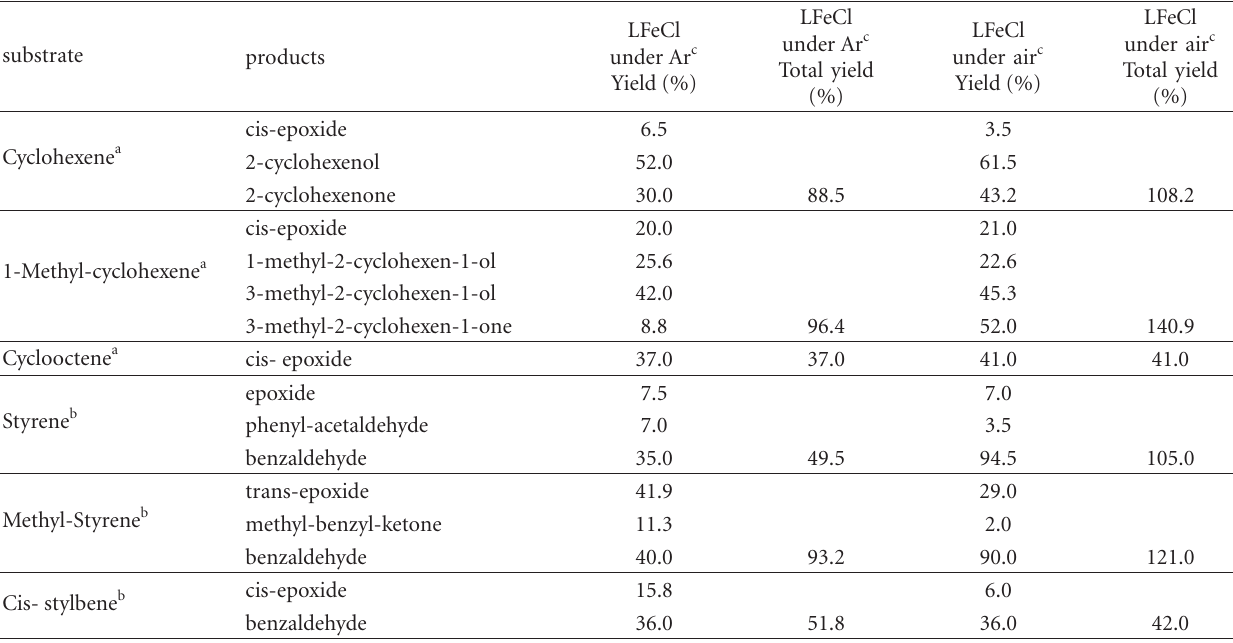
Table 1: Hydrocarbon oxidations catalyzed by LFeCl with H 2 O 2 in CH 3 CN under atmospheric air and under Ar.